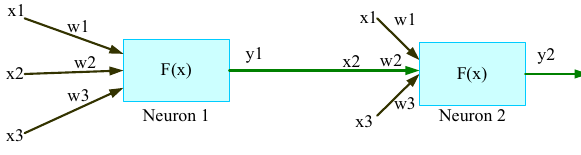
Figure 6: Neuron